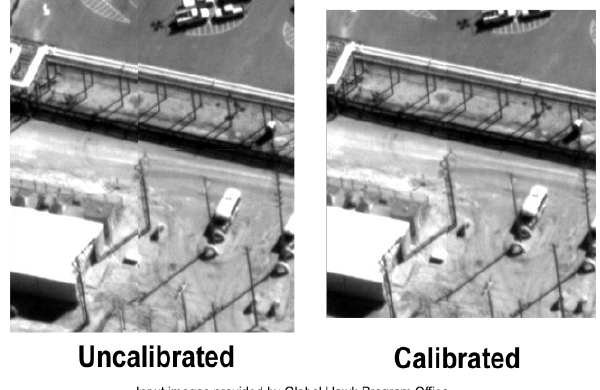
Figure 10. GH UAV - zoomed in version of Example 2. Notice undesirable shift in linear features in Uncalibrated